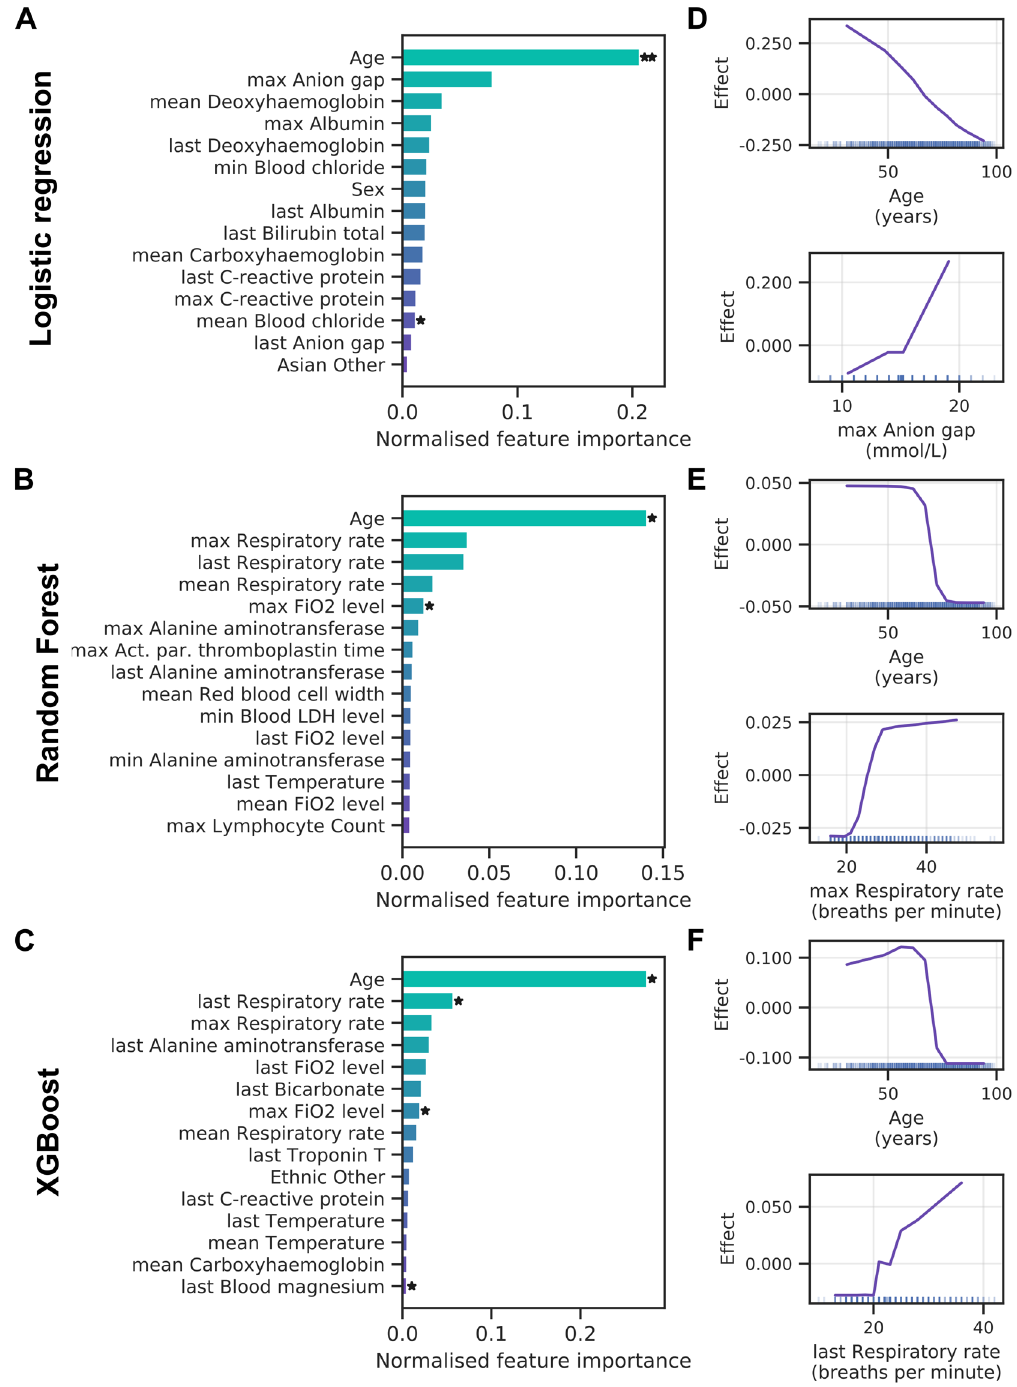
Figure 3. Feature importance for AICU admission. ( A–C ) Permutation feature importance for the logistic regression ( A ), random forest ( B ) and XGBoost ( C ) models. Only the top 15 features are shown. Asterisks mark features with importance scores significantly different from zero across three cross-validation folds with t-test p value thresholds of 5% ( *) and 1% (* *). ( D–F ) Accumulated local effects plots for the logistic regression ( D ), random forest ( E ) and XGBoost models ( F ). The top two features according to permutation feature importance are shown for each model. Vertical bars at the bottom indicate feature values observed in the data